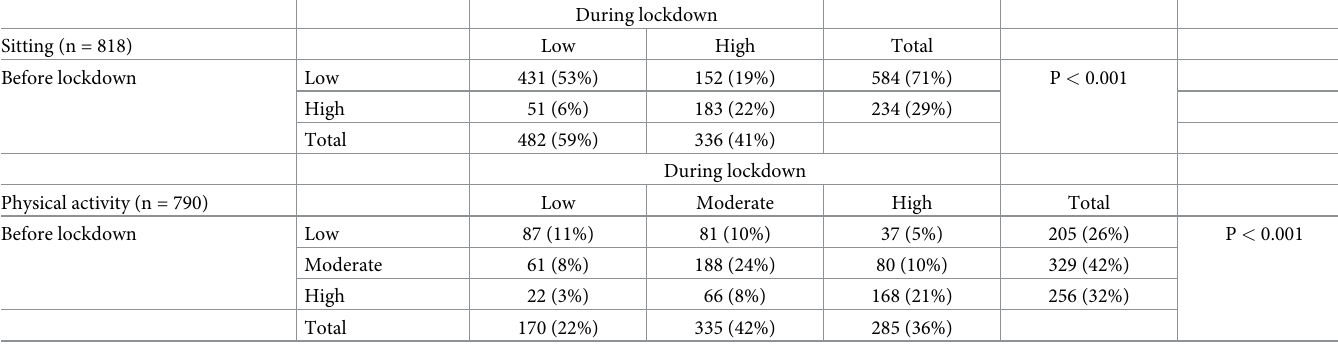
Walking and total physical activity significantly increased during lockdown by 241 (95% confi- dence interval [CI]: 176, 304) MET-min/week and 302 (CI: 155, 457) MET-min/week, respec- tively (P < 0.001). Moderate (16 [CI: -34, 63] MET-min/week, P = 0.50) and vigorous physical activity (44 [CI: -49, 139] MET-min/week, P = 0.35) during lockdown was not significantly dif- ferent compared with before lockdown. Physical activity (MET-min/week) before and during lockdown is shown in Fig 1. The proportion of participants engaging in low, moderate and high physical activity levels is shown in Table 2. Pearson’s Chi-squared was significant, demon- strating that the proportion of participants in the low, moderate and high categories signifi- cantly differed before and during lockdown (P < 0.001). There was a 4% decrease (from 26 to Table 2. Physical activity level and weekday sitting categories before and during lockdown. Data presented as n (%). During